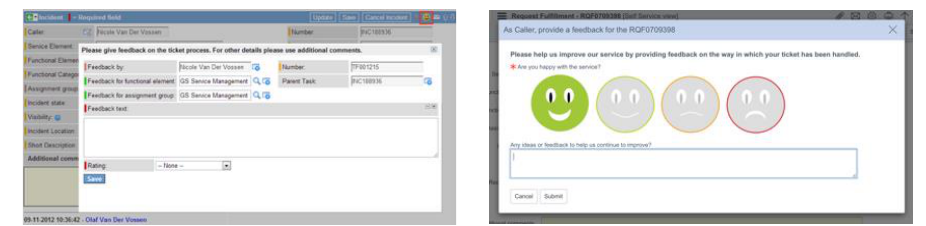
Fig. 4. Old (left) and new (right) ticket feedback